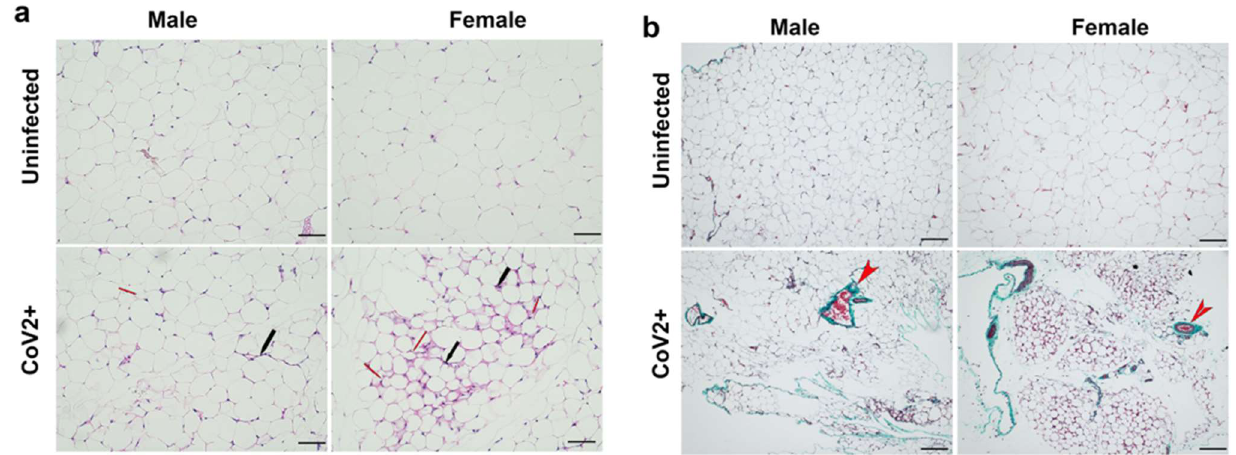
Figure 1. SARS-CoV-2 infection alters adipose tissue morphology at 10 DPI in hACE2 mice ( n = 4 mice/sex). ( a ) H&E-stained sections of WAT of both males and females showing infiltrated immune cells (black arrow) and loss in lipid droplets (red arrow, smaller adipocytes) with CoV-2 infection compared to uninfected mice (20× magnification, scale bar—50 µm); ( b ) Masson-trichrome staining of WAT sections showing fibrosis and collagen (green color, red arrowhead) in CoV-2 infected mice (10× magnification, scale bar—100 µm).